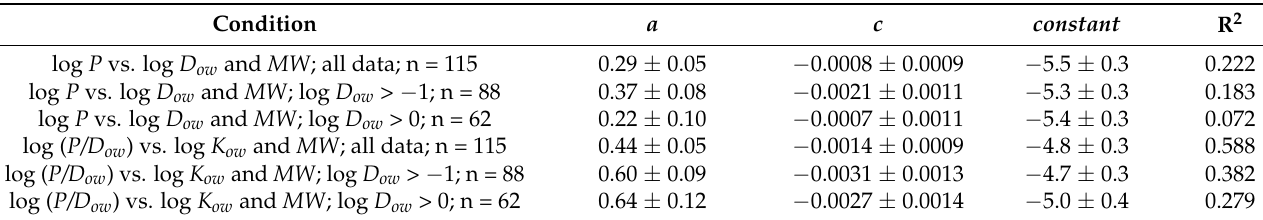
Figure 3. Relationship between log P and log D ow for all applicable permeants in Table A1. Table 2. Regression analysis results of log P with log D ow and MW as independent variables (first three rows) and log ( P/D ow ) with log K ow and MW as independent variables (last three rows), using the data of all permeants and then permeants with log D ow > − 1 and > 0. The parameters are defined in Equations (6) and (10). The values presented are the least squares means and standard errors of the